Question: What kind of plot is shown here?
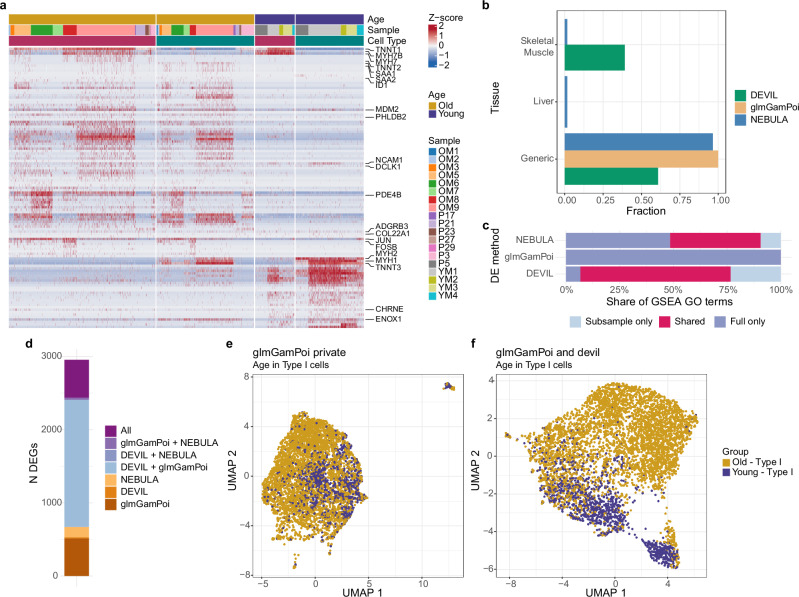
Answer: heatmap